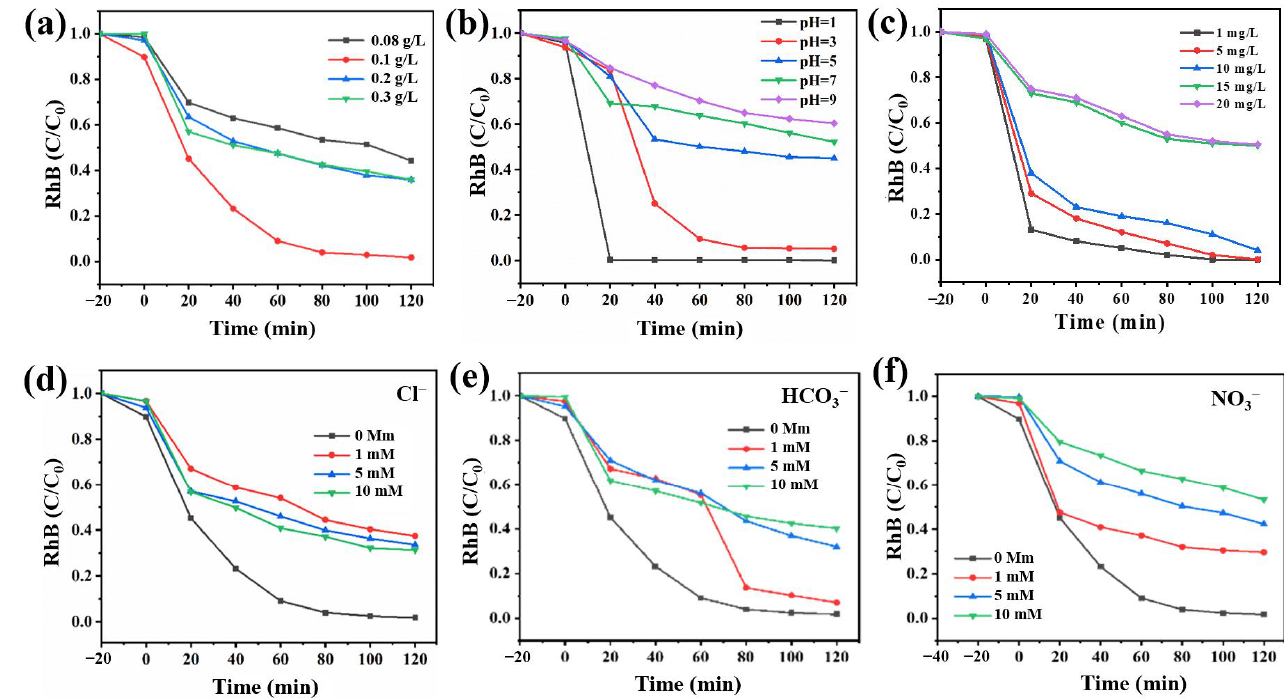
Figure 4. ( a ) The influence of catalyst concentration on RhB degradation. ( b ) The influence of pH on RhB degradation. ( c ) The influence of RhB concentration on its degradation performance. ( d ) The influence of Cl − on RhB degradation. ( e ) The influence of HCO 3 − on RhB degradation. ( f ) The influence of NO 3 − on RhB degradation. Test conditions if there is no special statement: 0.1 g/L BTO-180; 10 mg/L RhB; 0.2 g/L PMS.